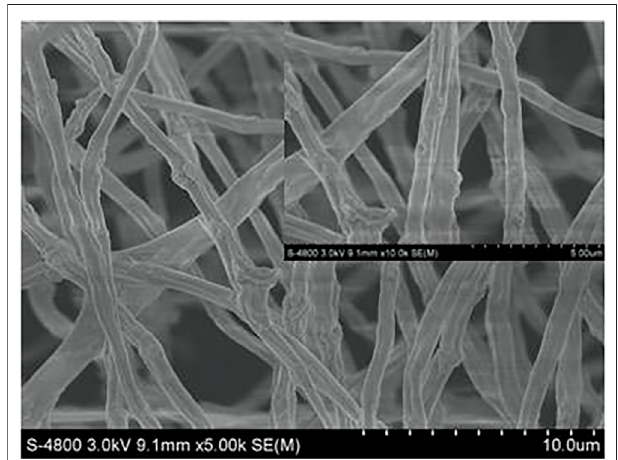
FIGURE 3 | Unsmooth fi bers by controlling the bubble